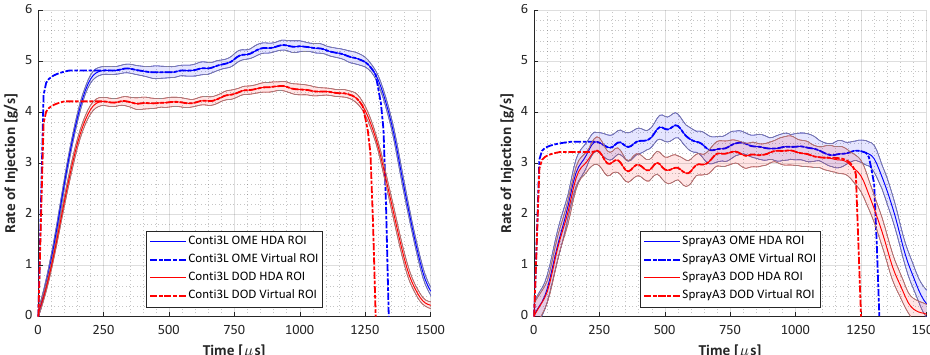
Figure 3. Virtual rate of injection used as CFD boundary condition (p inj = 1500 bar, p CC = 60 bar and t inj = 1.5 ms ): ( left ) Conti3L. ( right )